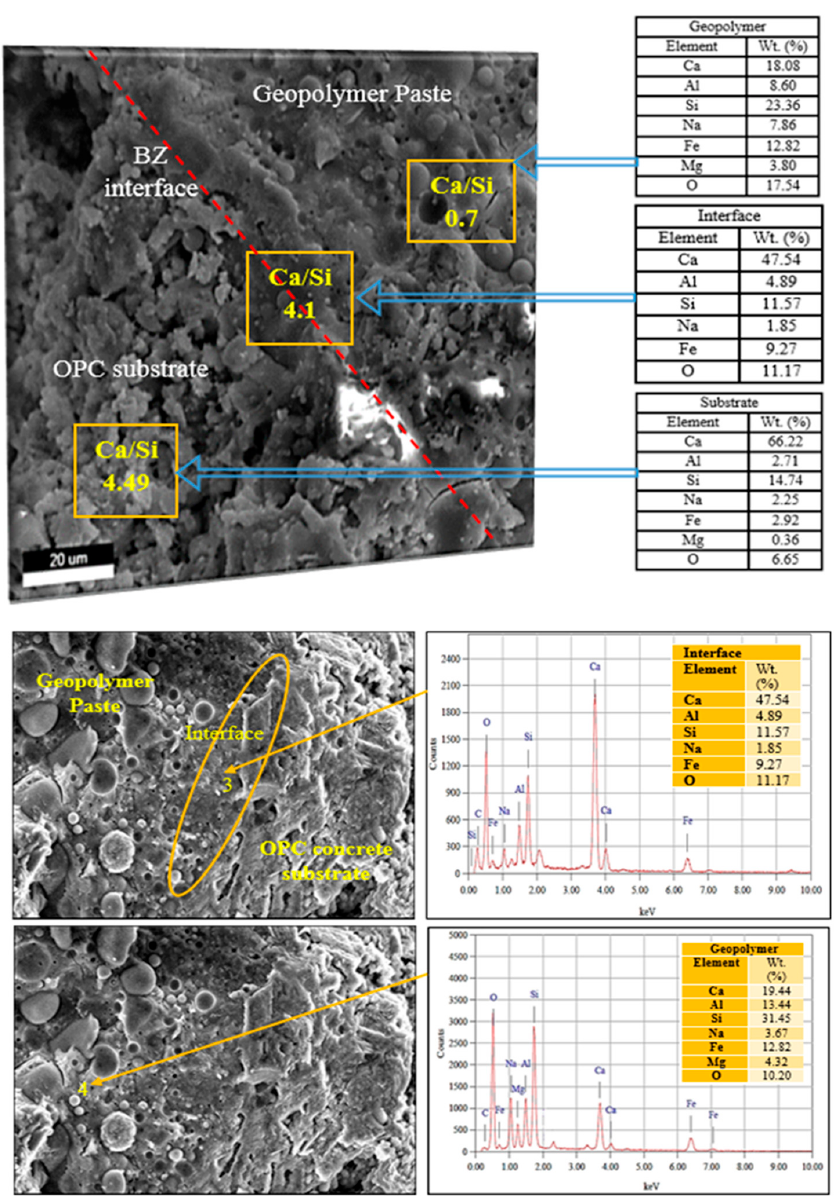
Figure 10. Elemental composition in various areas as given by EDX analysis.